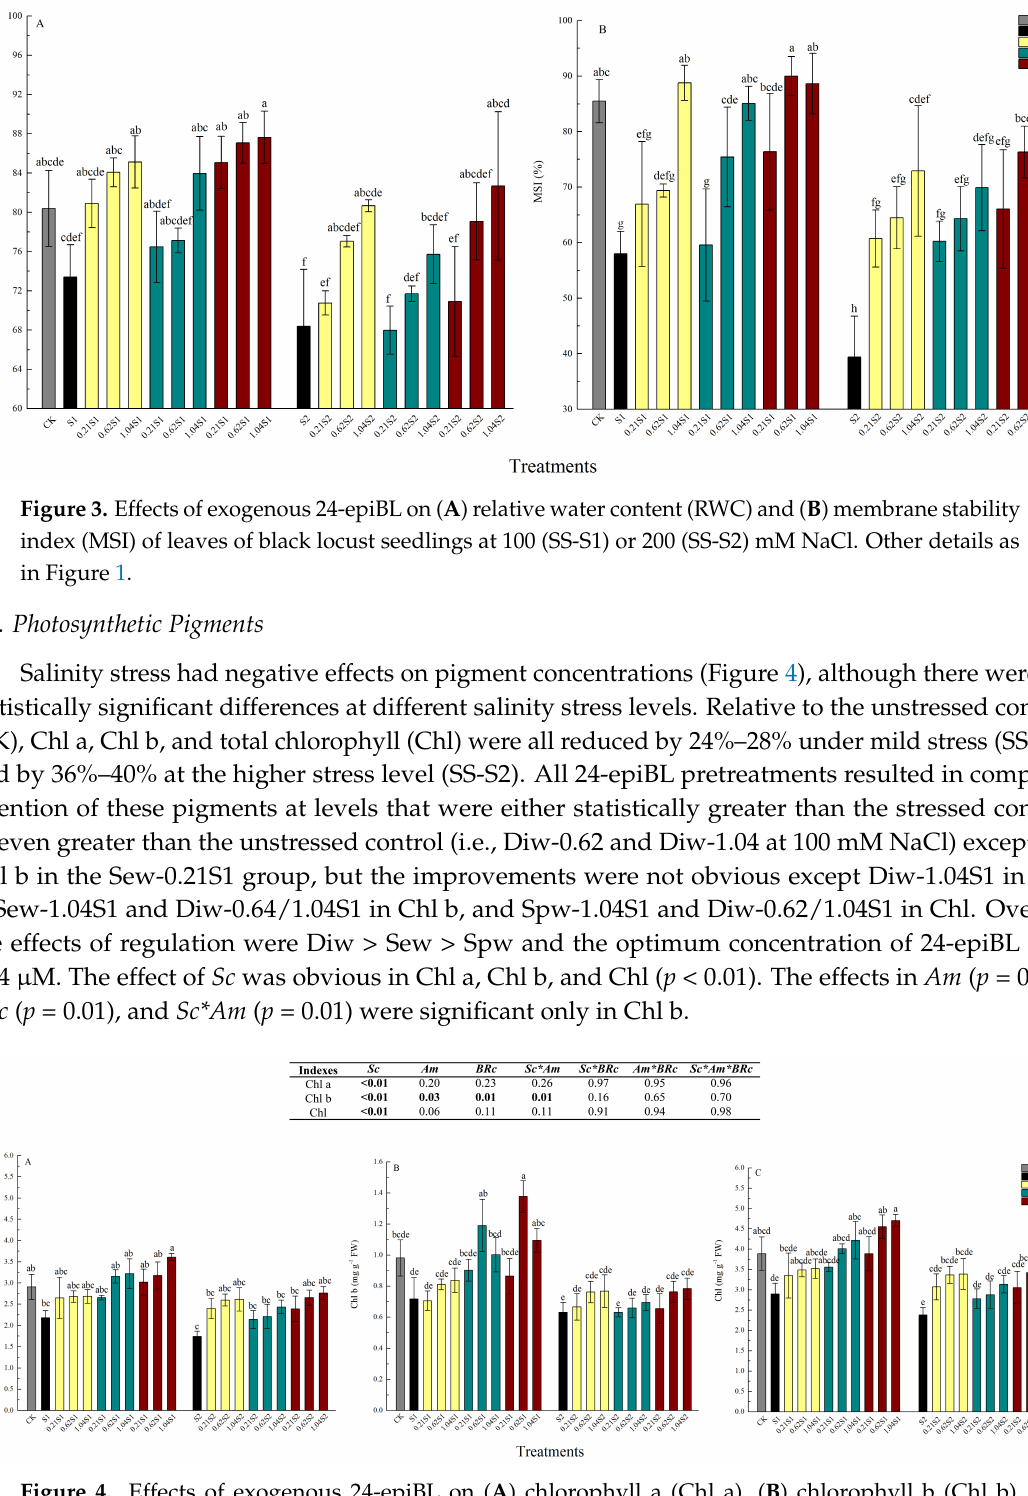
Figure 4. Effects of exogenous 24-epiBL on ( A ) chlorophyll a (Chl a), ( B ) chlorophyll b (Chl b), and ( C ) total chlorophyll (Chl) of leaves of black locust seedlings at 100 (SS-S1) or 200 (SS-S2) mM NaCl. Other details as in Figure